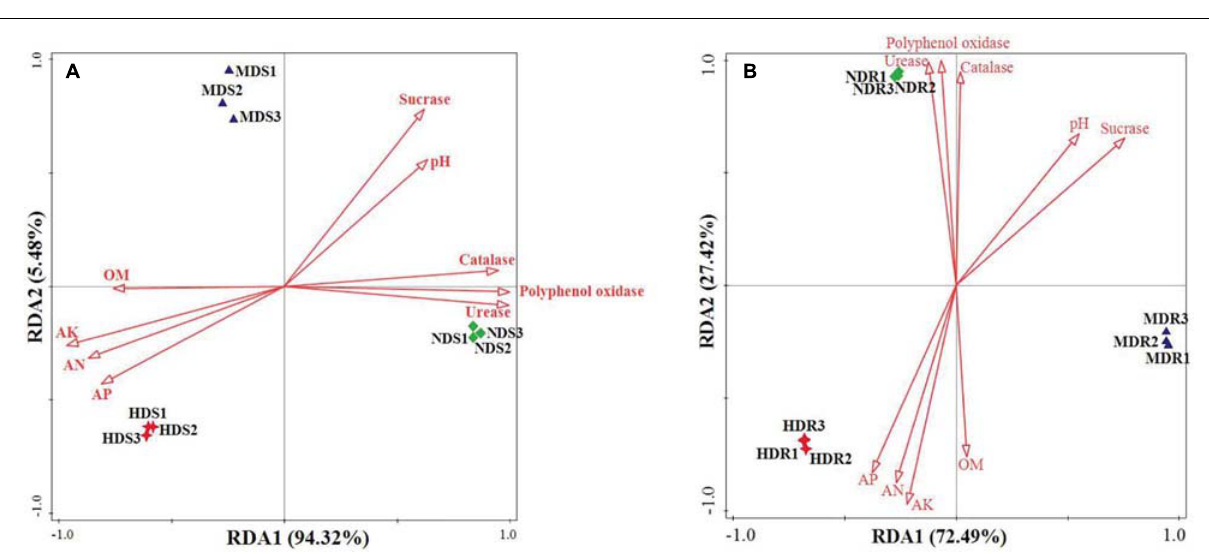
FIGURE 7 | Redundancy analysis revealing the effects of different degrees of soft rot disease on soil variables and bacterial community structure (genus level) in the soil (A) and root (B) samples of konjac from the non-diseased (NDS and NDR), moderately diseased (MDS and MDR), and highly diseased (HDS and HDR) sites. OM, organic matter; AN, alkaline-hydrolyzable nitrogen; AK, available potassium; and AP, available